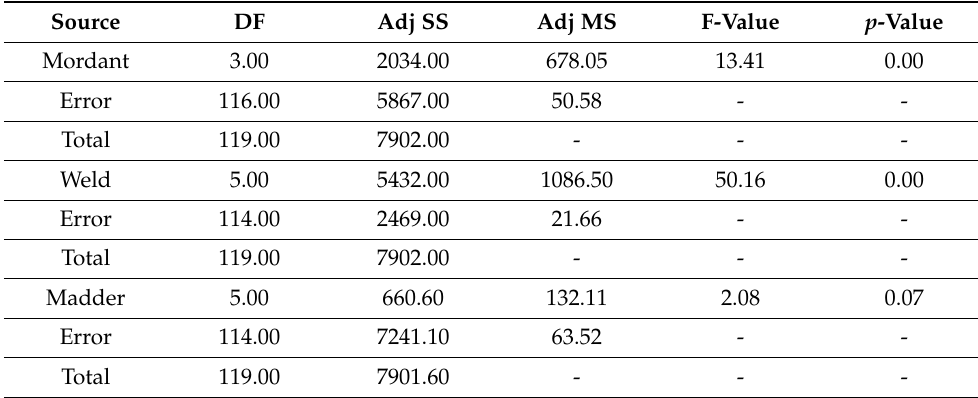
Table 1. Results of ANOVA for l* color coordinate.